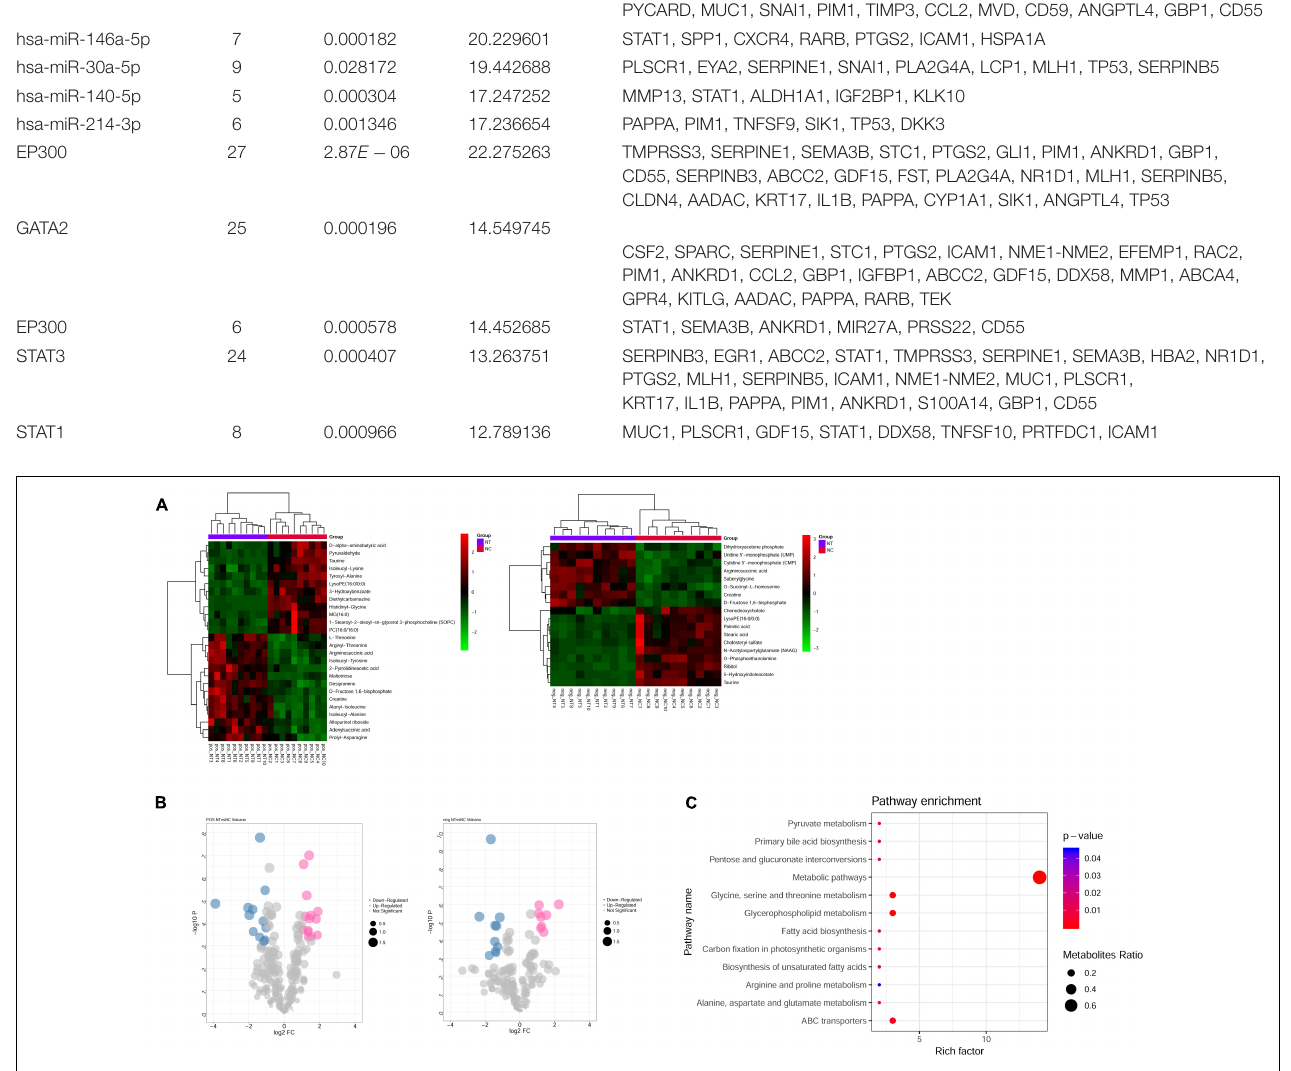
FIGURE 5 | Identification of differential metabolites between NTPCR groups and normal groups. (A) Hierarchical clustering analysis was performed for differential metabolites in NTPCR vs. normal control samples under ESI + ion (left) and ESI- ion (right) modes. Green represent downregulated metabolites, while red refer to upregulated metabolites. (B) Volcano plot of differential metabolites in NTPCR vs. normal control samples under ESI + ion (left) and ESI- ion (right) modes. Blue dots are downregulated metabolites, pink dots refer to upregulated metabolites, and gray dots represent normal metabolites. The dot size was correlated with VIP